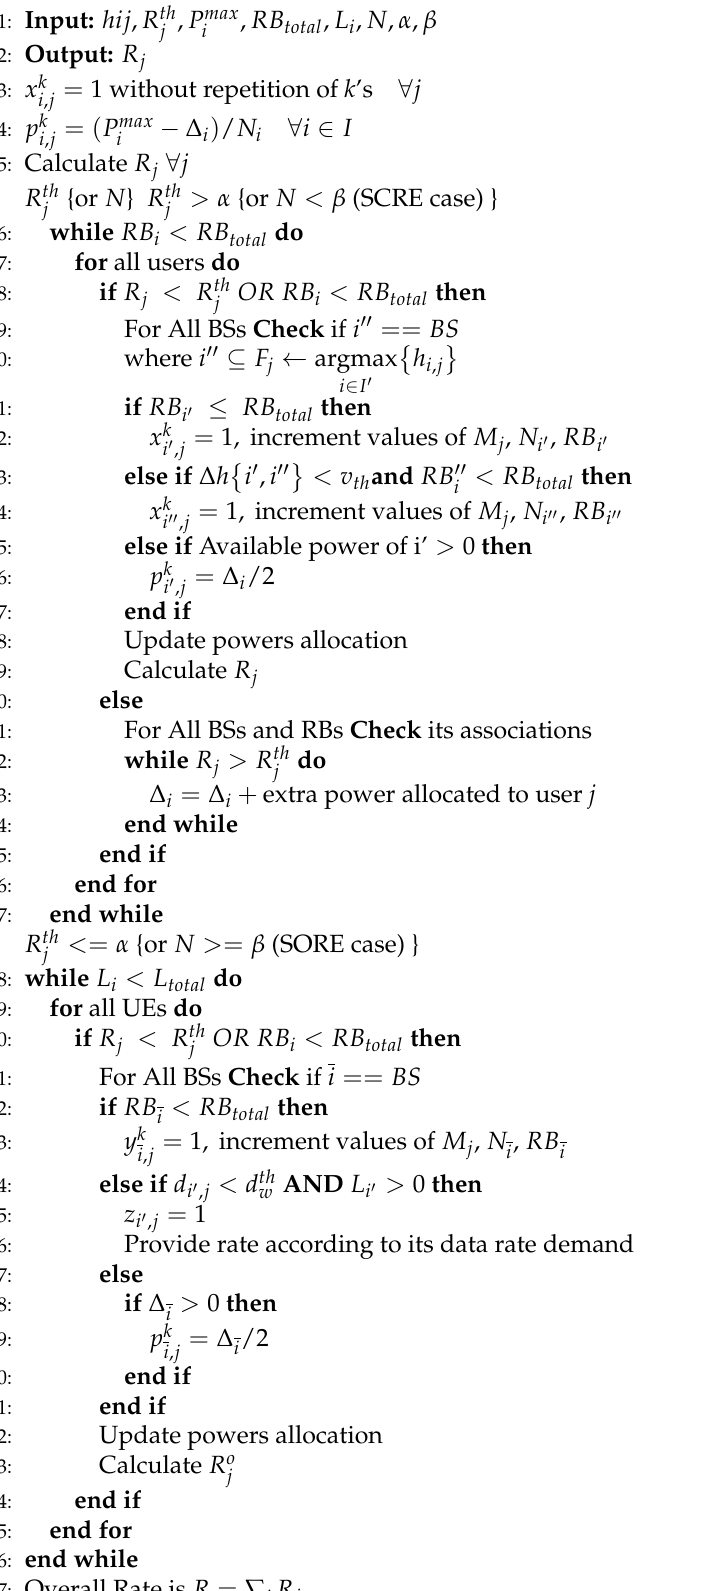
Algorithm 3 Switching between Cooperation and Offloading